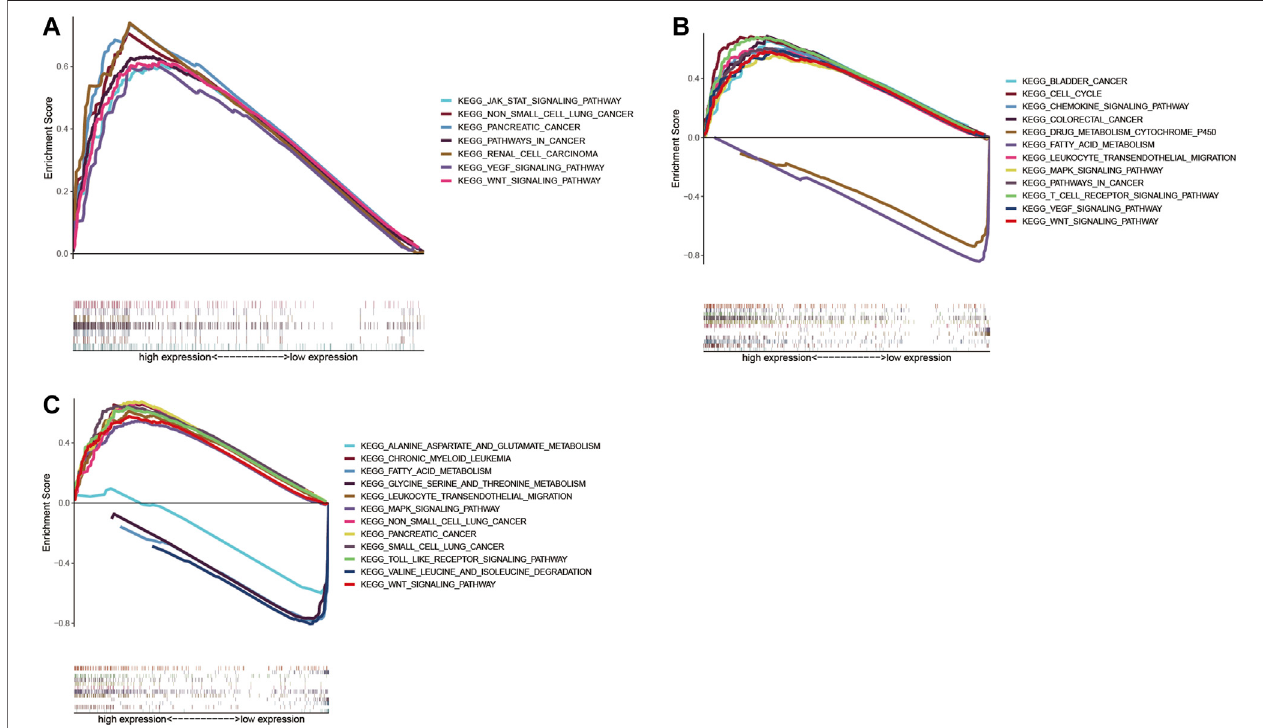
FIGURE13| Genesetenrichmentanalysis(GSEA)ofsigni fi cantprognosticArp2/3subunitsinHCCbasedonthecancer-relatedKyotoEncyclopediaofGenesand Genomes (KEGG). (A) ACTR3; (B) ARPC2; and (C) ARPC5.